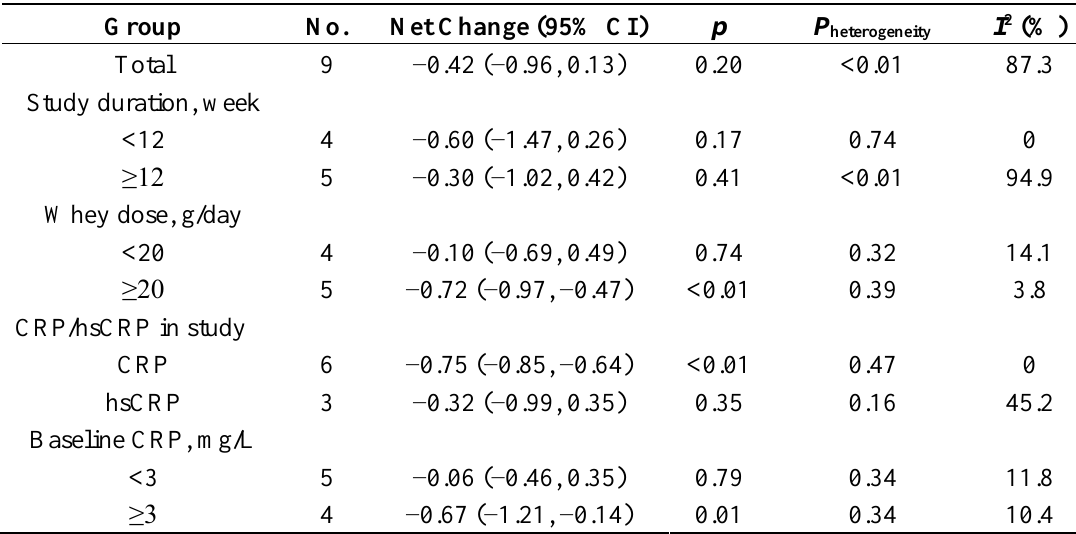
Table 2. Subgroup analyses according to study duration, daily whey supplementation and baseline CRP